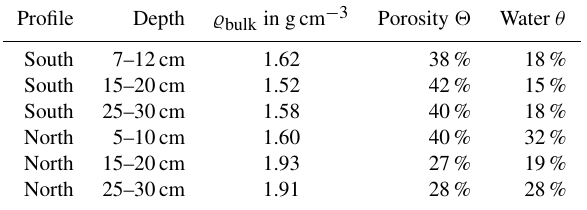
Table 1. Two soil profiles in the grass meadow sampled nearby the profiles of the wireless sensor network (WSN) on 14 January 2016. Samples were taken with core cutters of constant volume at three depths, oven-dried, and weighted according to standard procedures. The evaporated water content is given in units of volumetric